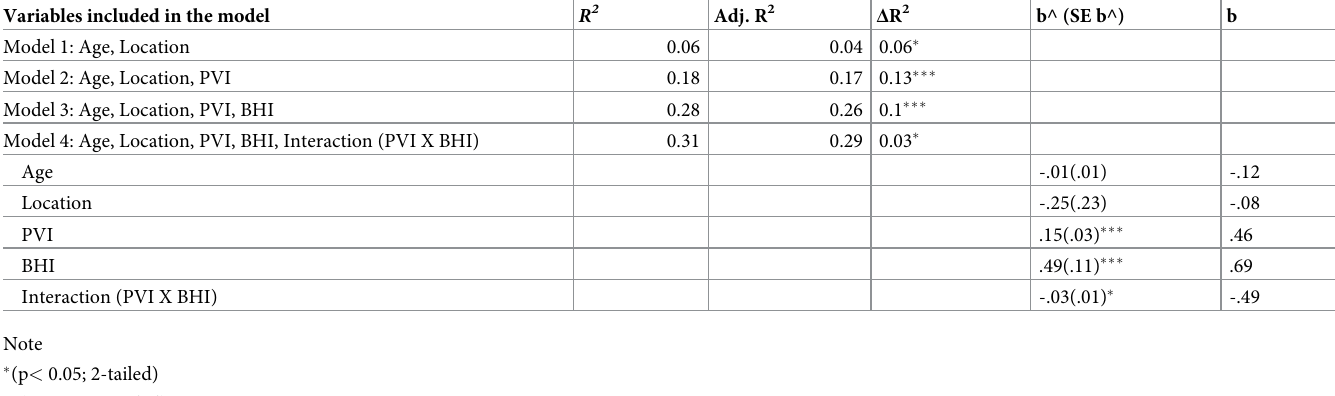
Table 5. Variance in symptoms of PTSD uniquely explained by polyvictimization and barriers to healthcare among the quantitative sample (N = 151). Variables included in the model